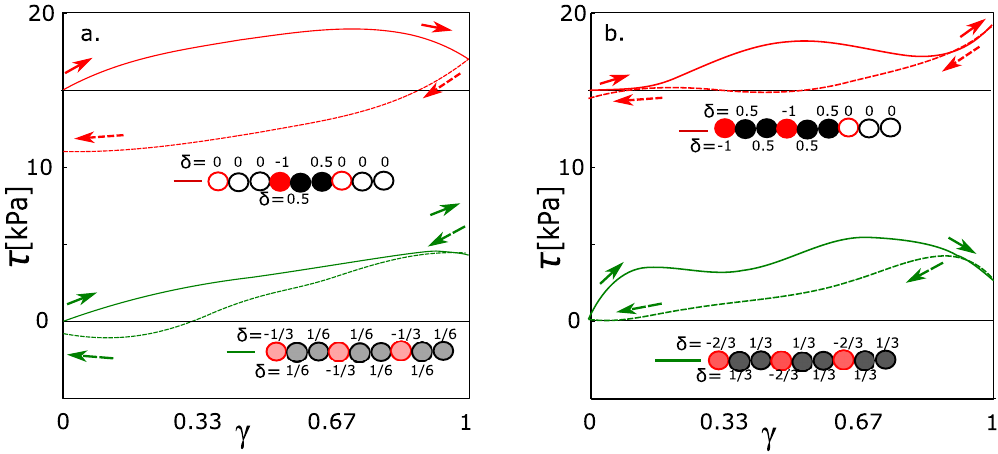
Figure 4. Stress-strain function. Green and red curves are with the same density of charge and different distribution: Green-charge uniformly distributed; red, the same average density as green, but the unity charge is accumulated on one monomer; ( a ) charge density 0.333 per monomeric unit; ( b ) charge density 0.667 per monomeric